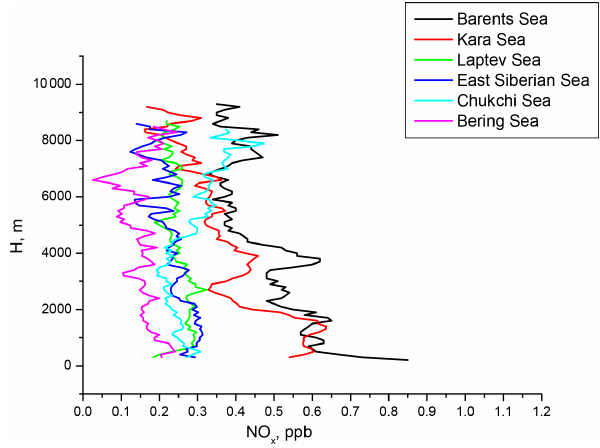
Figure 13. Vertical distribution of nitrogen oxides over sea